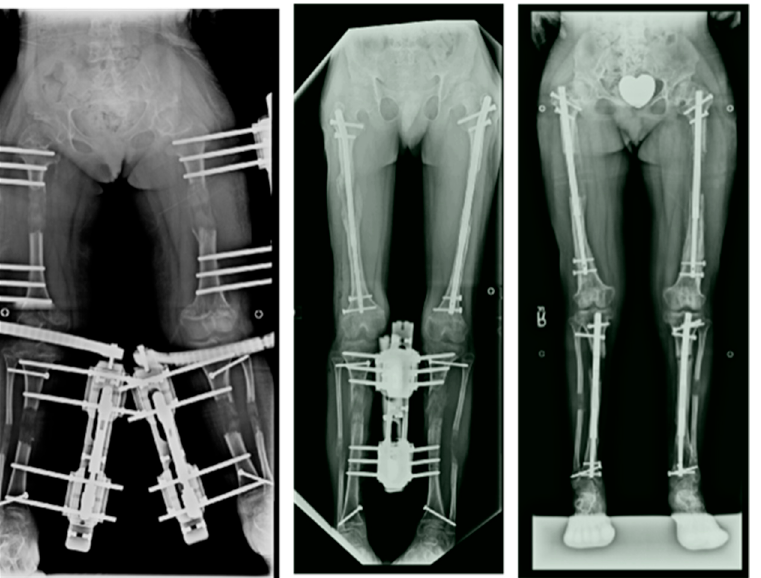
Figure 8. Radiographs showing 4-segment lengthening with: 4 external fixators ( left ); Hybrid, 2 implantable lengthening nails in both femurs and two external fixators ( middle ); and 4 implantable lengthening nails in both femurs and tibias.